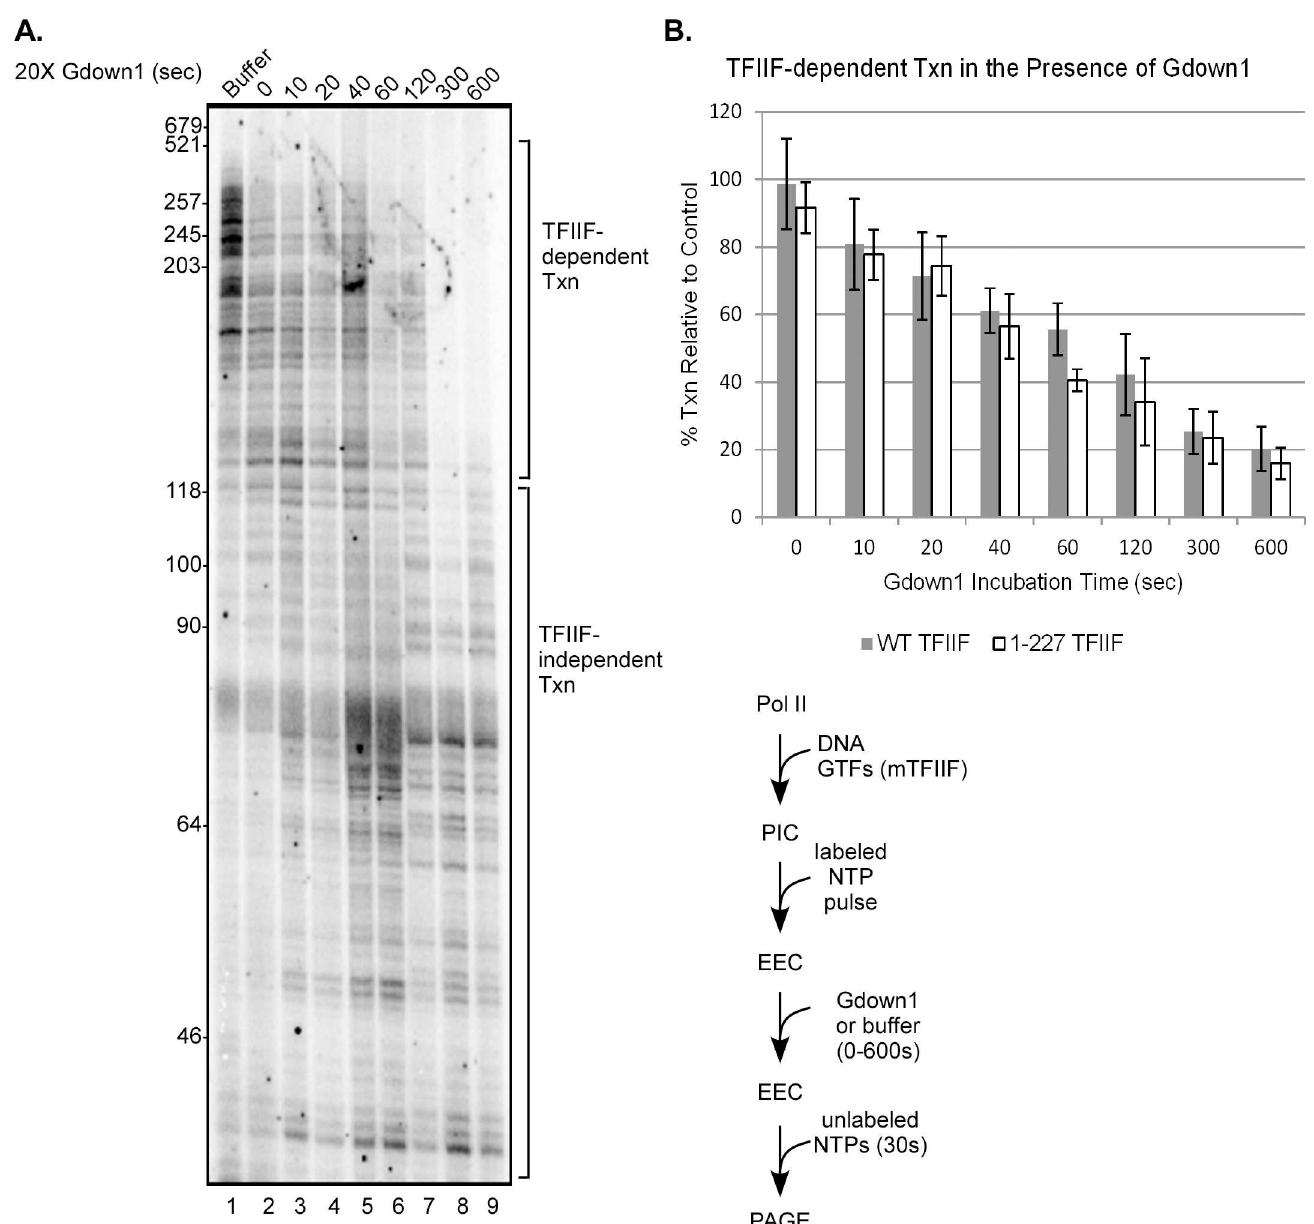
Fig 2. Truncation of the large subunit of TFIIF does not enhance functional Gdown1 loading to EECs. (A) PICs were assembled with 1–227 TFIIF and EECs were generated in solution on the AdML 31g(M) template with ATP, UTP and [ α - 32 P]CTP as describedin Materials and Methods. EECs were then incubated with 240 fmol of Gdown1 for 0 to 10 min (except lane 1) and chased for 30 sec with 200 μ M NTPs. Lengths of markers are shown on the left edge of the gel, and lengths of TFIIF-dependent and TFIIF-independent transcripts are noted on the right. A schematic of the assay is shown to the lower right of the gel. (B) Average percents of TFIIF-dependent transcription (open bars) were quantifiedfrom results like those shown in panel (A) as describedin Materials and Methods. The error bars indicate the mean ± S.D. based on four replicates. The grey bars duplicatethe values from Fig